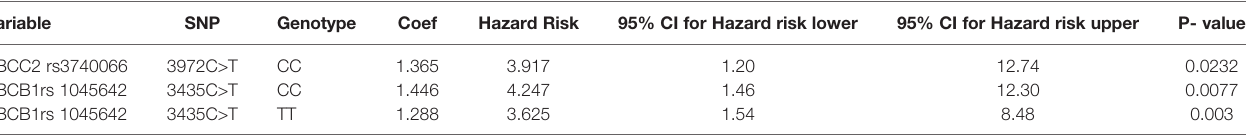
TABLE 4 | Cox regression model for SNPs and